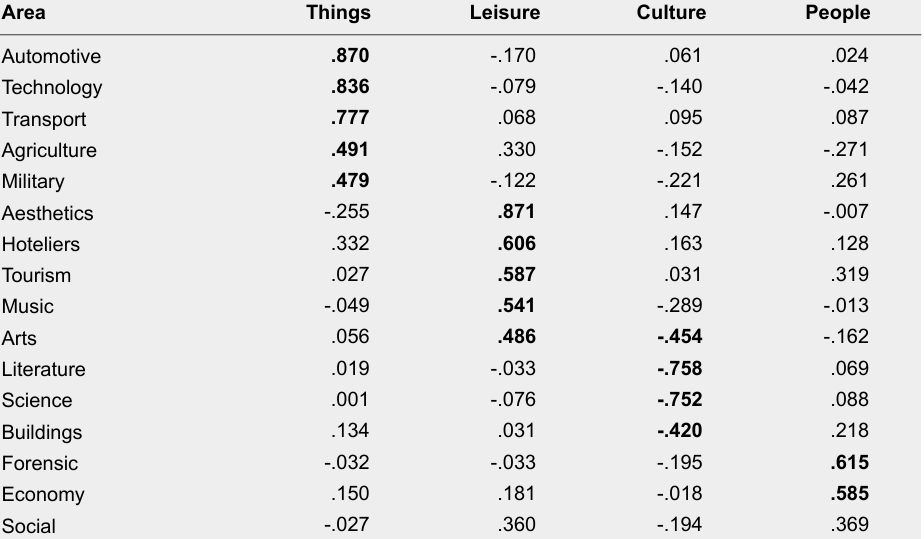
Model Matrix of Explorative Factorial